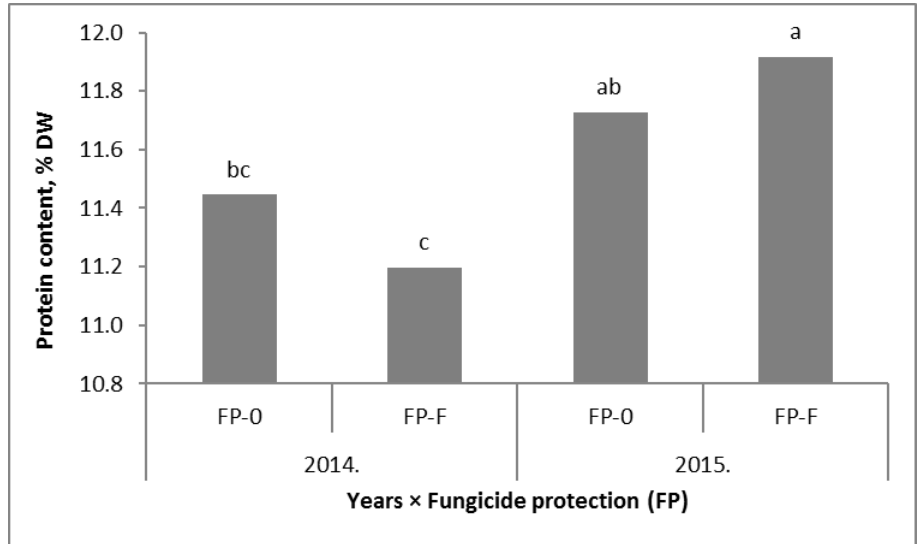
Figure A2. The content of protein in winter wheat grain in consecutive years of study on the background of plant protection. Similar letters in the column means a lack of significant differences using Tukey’s’ test . The vertical bar in the column refers to the standard error of the mean.